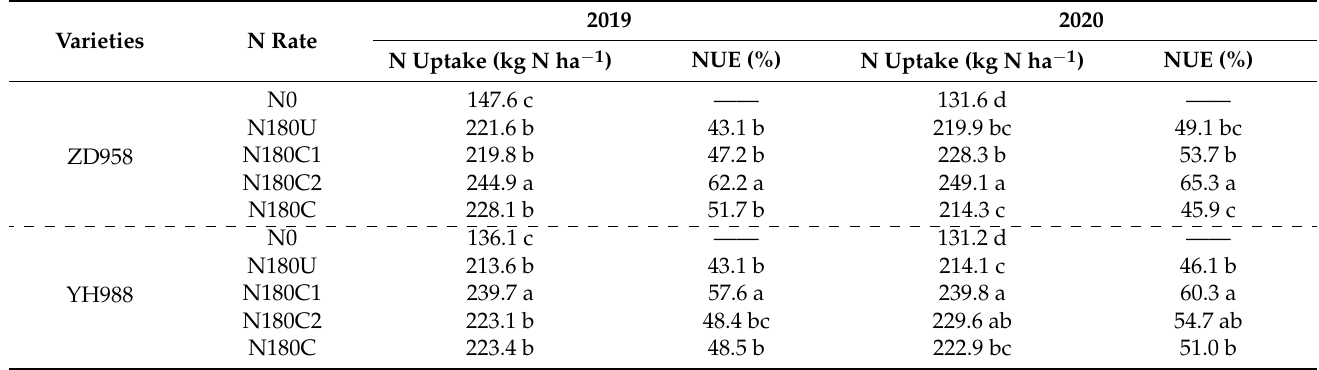
N0, no N; 180, 180 kg N ha − 1 ; U, solely urea; C1, ratio of controlled-release nitrogen to urea nitrogen is 1:2; C2, ratio of controlled release nitrogen to urea nitrogen is 2:1; C, all CRU. Mean values followed by different letters are significantly different at